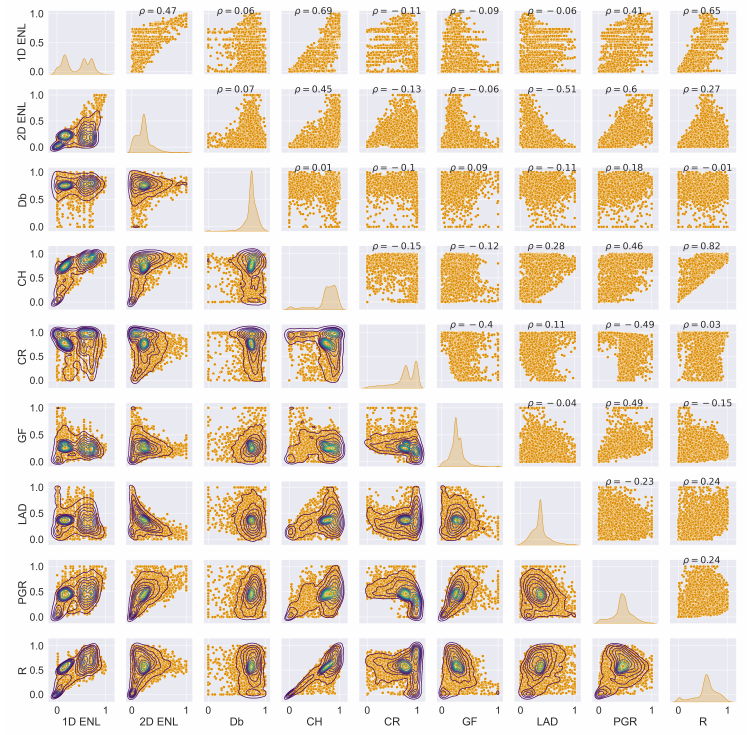
Figure A21. TLS traits plot at 1m grid